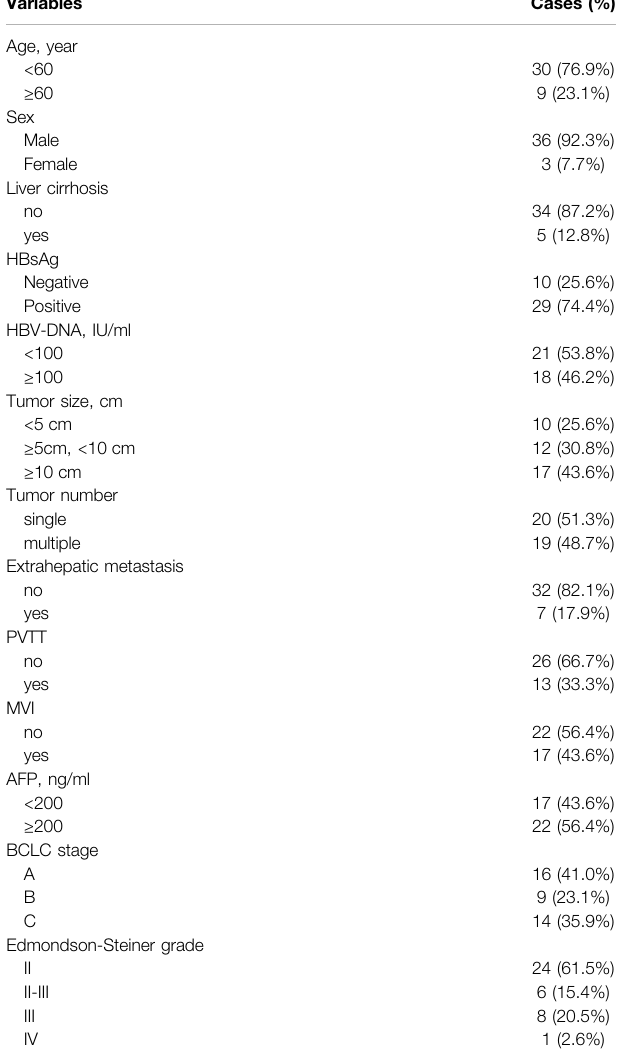
TABLE 1 | The clinical characteristics of HCC